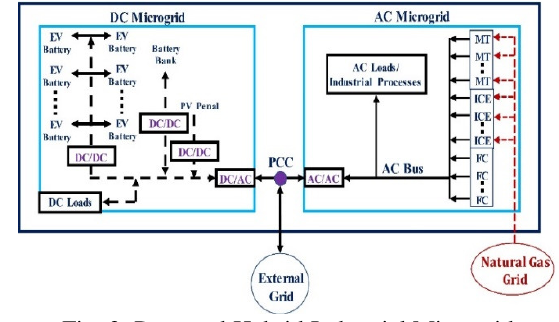
Fig. 2: Proposed Hybrid Industrial